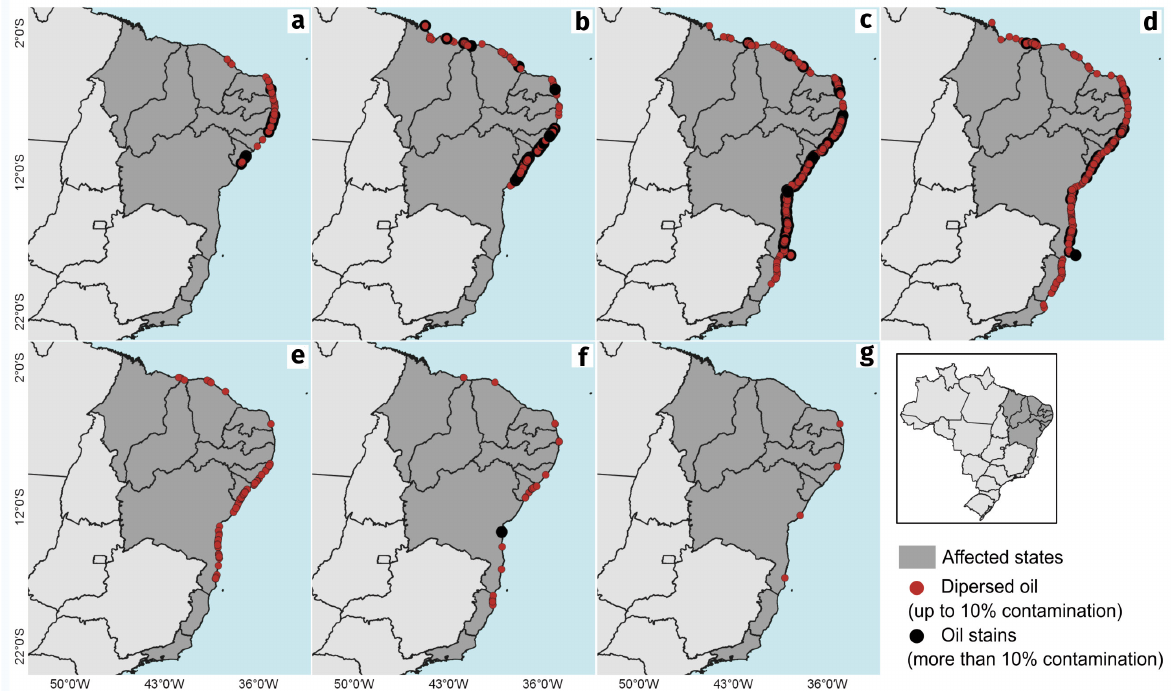
Figure 1. Non-cumulative observations of oil stains along Northeastern brazilian coast through months of the disaster. Note: biweekly observations. a: Aug-Sep; b: Sep-Oct; c: Oct-Nov; d: Nov-Dec; e: Dec-Jan ; f: Jan-Feb; g: Feb- Mar. Source: adapted from The Brazilian Institute of the Environment and of Renewable Natural Resources (Ibama